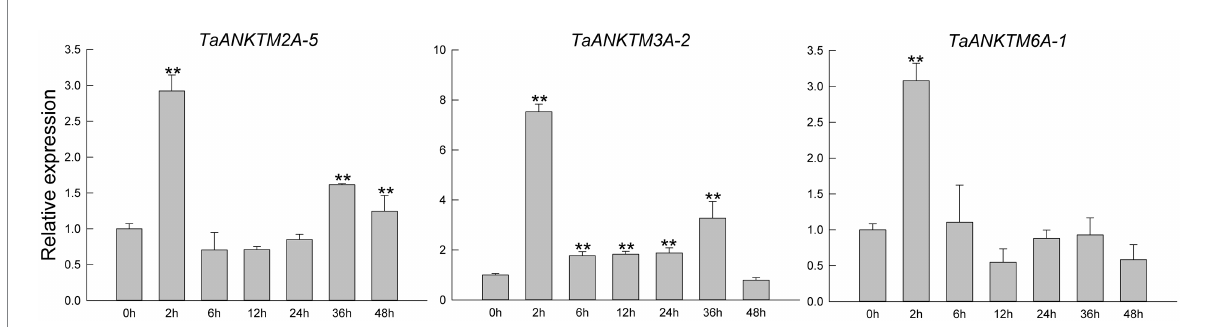
FIGURE 5 Expression profiling of three TaANKTMs in common wheat AK58 after Bgt inoculation by qRT-PCR. Relative expression of three TaANKTMs in response to Bgt . Data were normalized to the TaTubulin gene. The values are the means of three technical replicates of one biological experiment. Asterisks indicate significant differences (assessed using Duncan’s honestly significant difference test), ** p < 0.01. All the raw data for qRT-PCR are listed in Supplementary Table 3.